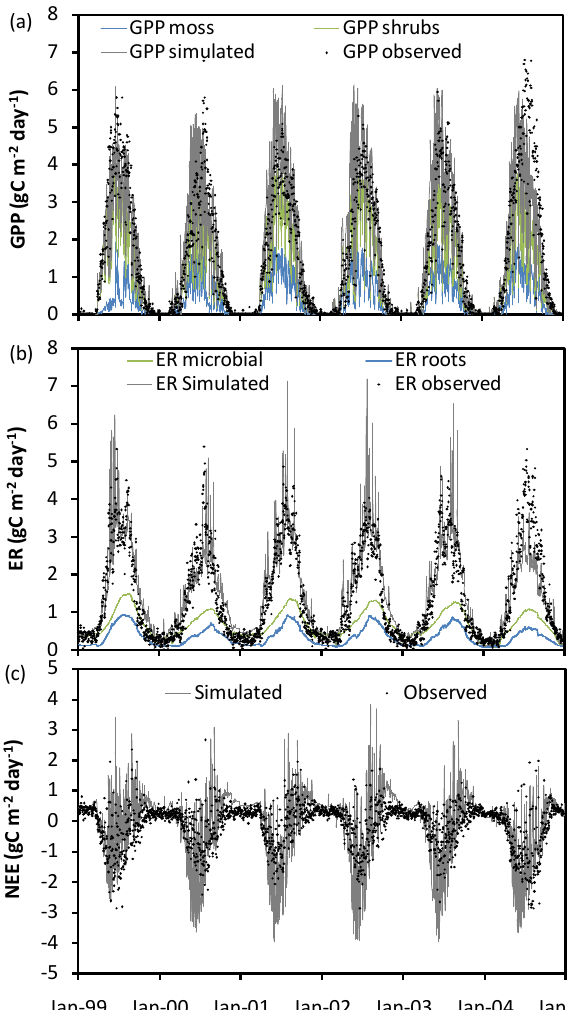
Fig. 6. Time series of daily observed average (symbols) and daily simulated (line) GPP and components (a) , ER and its components (b) , and NEE (c) for 1999–2004